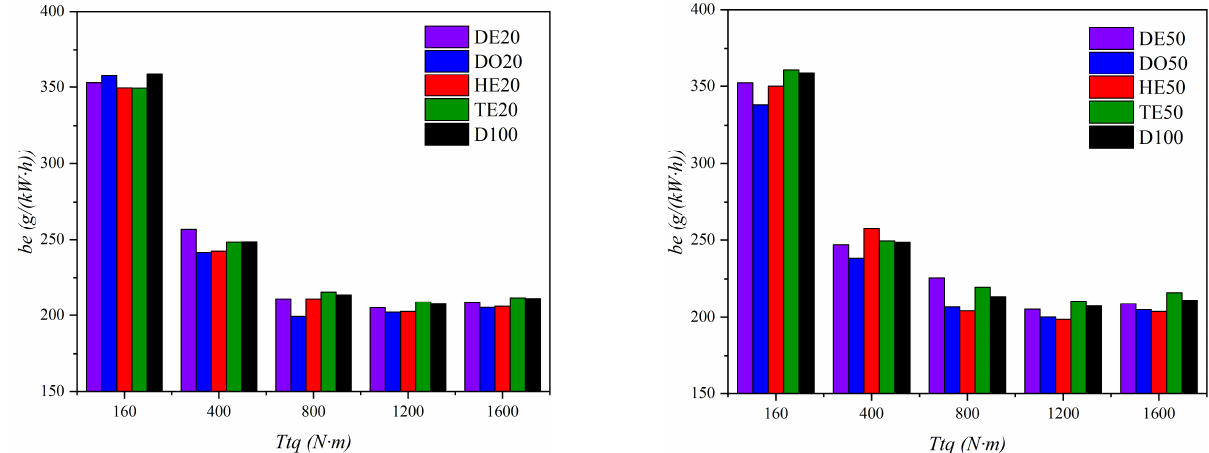
Figure 6. Effective specific fuel consumption at 1900 r/min.